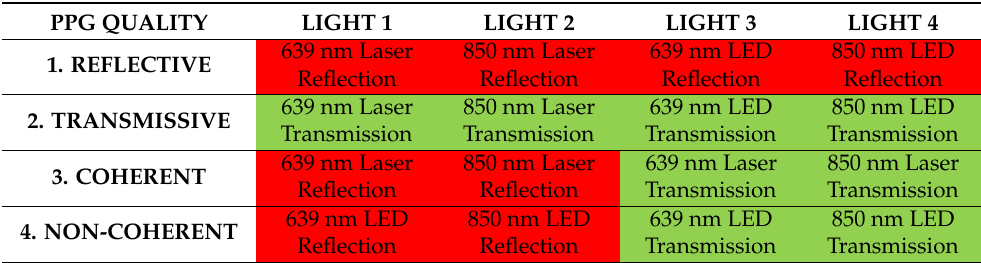
Table 2. Summary of signal quality findings on PPG. Green represents a high frequency density of PPG primary peak and harmonics compared with the system noise (SQI average > 0.85). Red represents a low frequency density of PPG primary peak and harmonics compared with the system noise (SQI average <